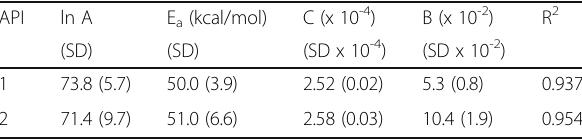
Table 3 Regression coefficients for data fitted to the modified Arrhenius equation (Eqs. 2 and 3) and the Dimensionless equation (Eq. 4) for the two active ingredients